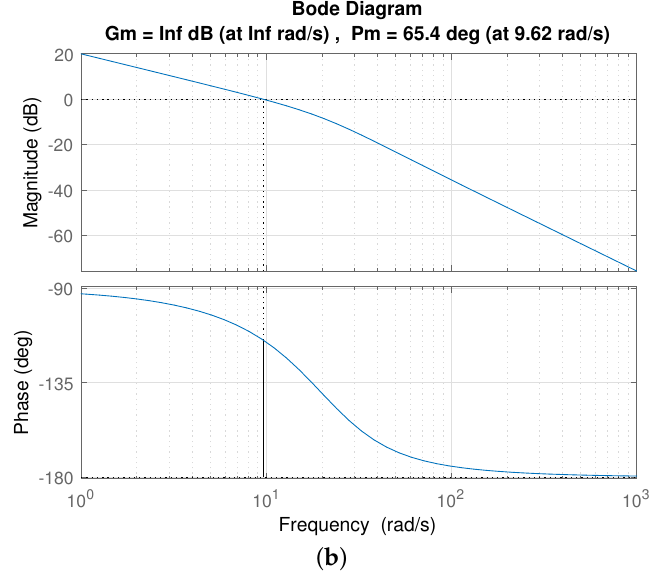
Figure 16. Origami system identification. Step response in closed loop ( a ); Bode diagram in open loop ( b ).